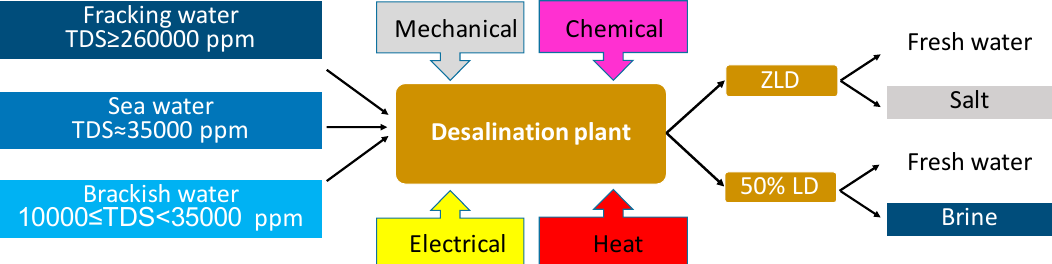
Figure 2. Inputs and outputs of a typical desalination process. TDS, total dissolved salts; LD, liquid discharge; ZLD, zero liquid discharge.